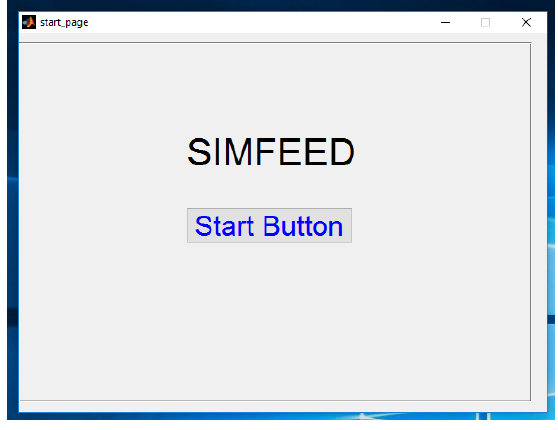
Figure 1. Initialization of the simulation tool